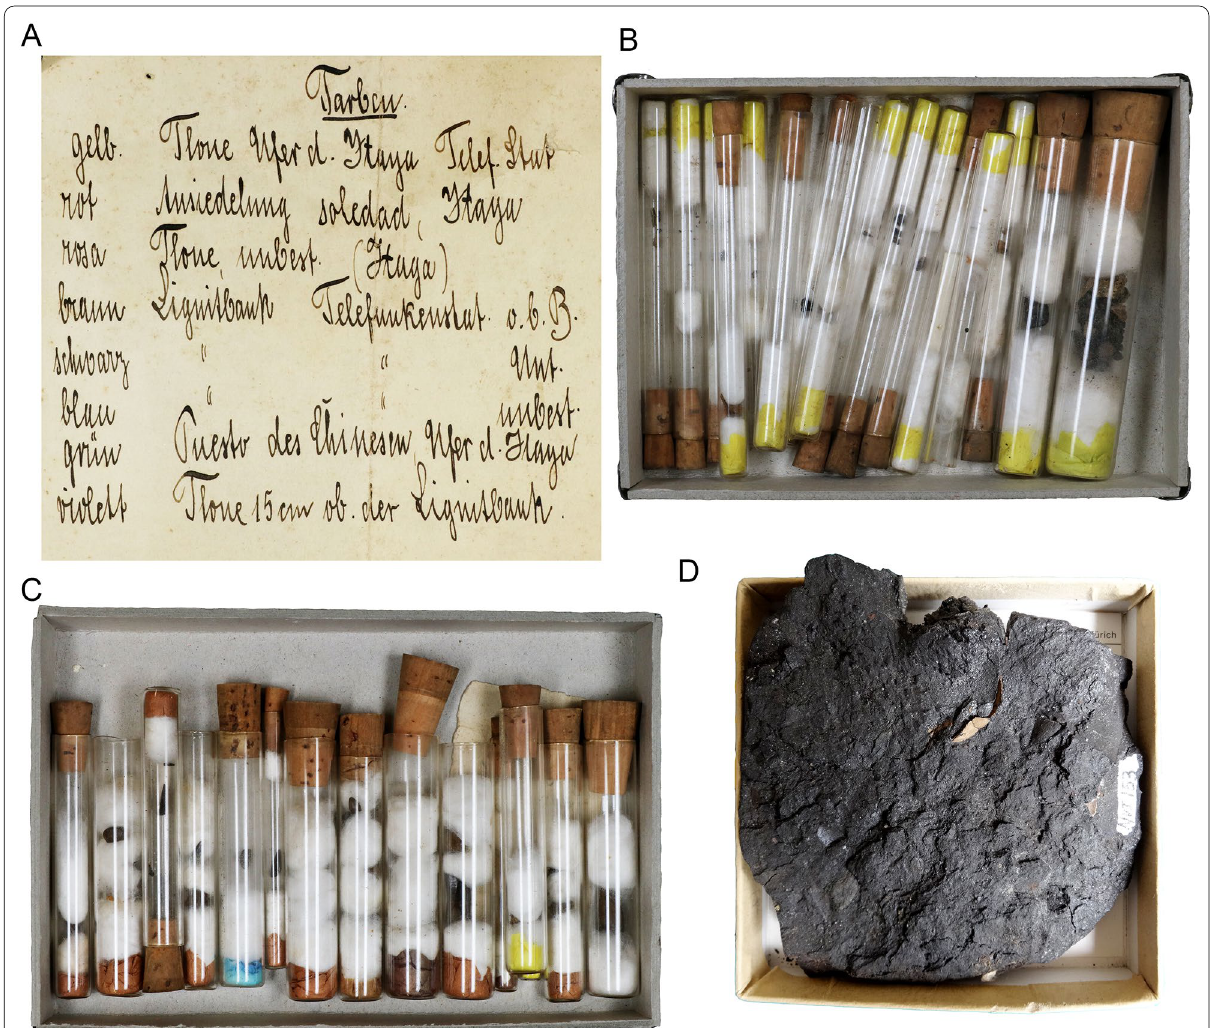
Fig. 2 Labels, fossil and geological samples from Iquitos collected during the Bluntschli and Peyer expedition of 1912. A Original label describing the fossiliferous layers (for translation and more details see Table 1). B , C Boxes with glass tubes containing the small fossil vertebrates and with papers of different colours indicating the different fossiliferous layers (e.g., see A ). D Lignite sample collected from the lignite layer at the Telefunken